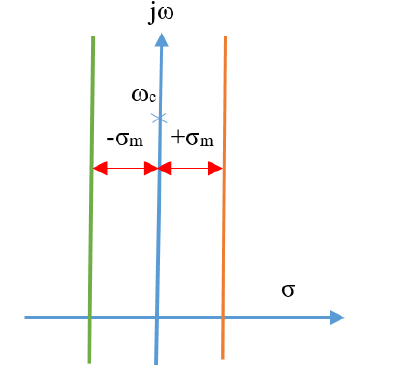
Figure 3. The crossing